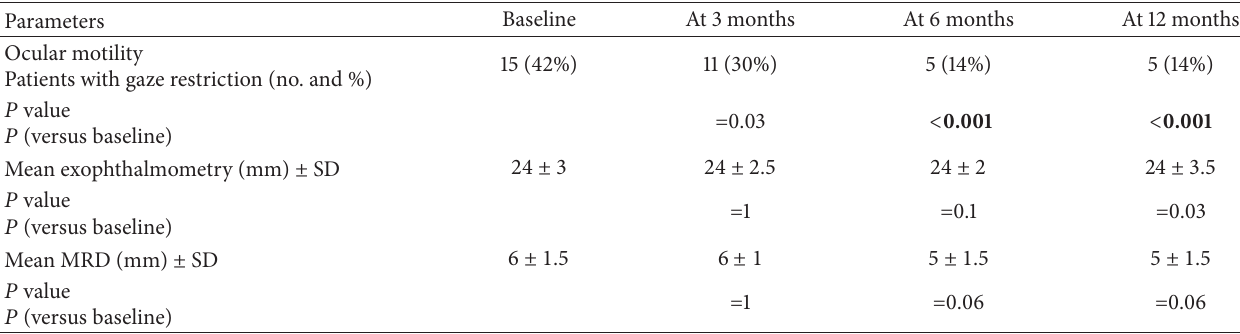
Table 3: Ocular motility, exophthalmos, and MRD results before and after 3, 6, and 12 months of methotrexate therapy.